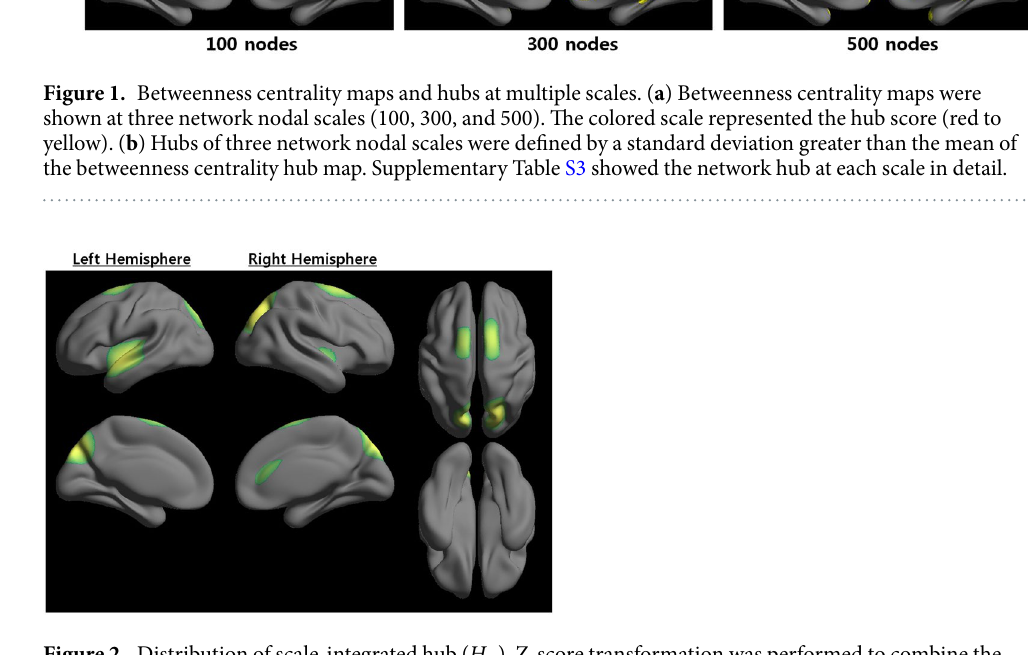
Figure 2. Distribution of scale-integrated hub ( H IS ). Z-score transformation was performed to combine the group hub scores from the different scales. Note that the scale-integrated hub score ( H IS _ SC ) captured how ‘well connected’ node i was to other nodes in the scale-integrated hub strength ( H IS _ ST ) map. Regions with a high H IS _ SC might also indicate a fundamental hub with high consistency across the nodal scale. Note that Table 2 showed the H IS regions in